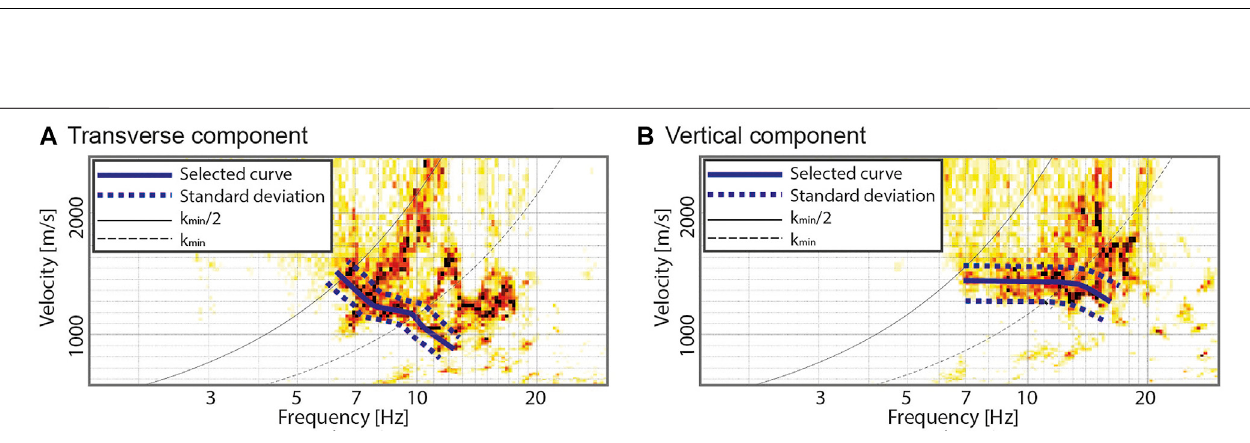
Frontiers in Earth Science |